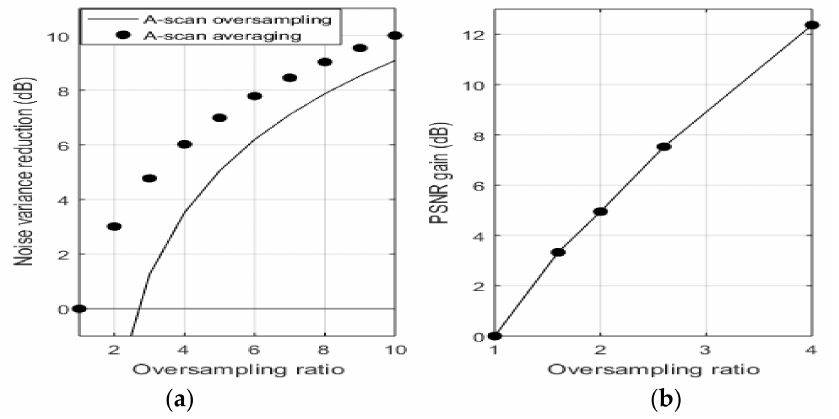
Figure 5. ( a ) Theoretical minimum noise variance reduction for different oversampling ratios; ( b ) PSNR gain in reconstructed salamander embryo images for different oversampling ratios.